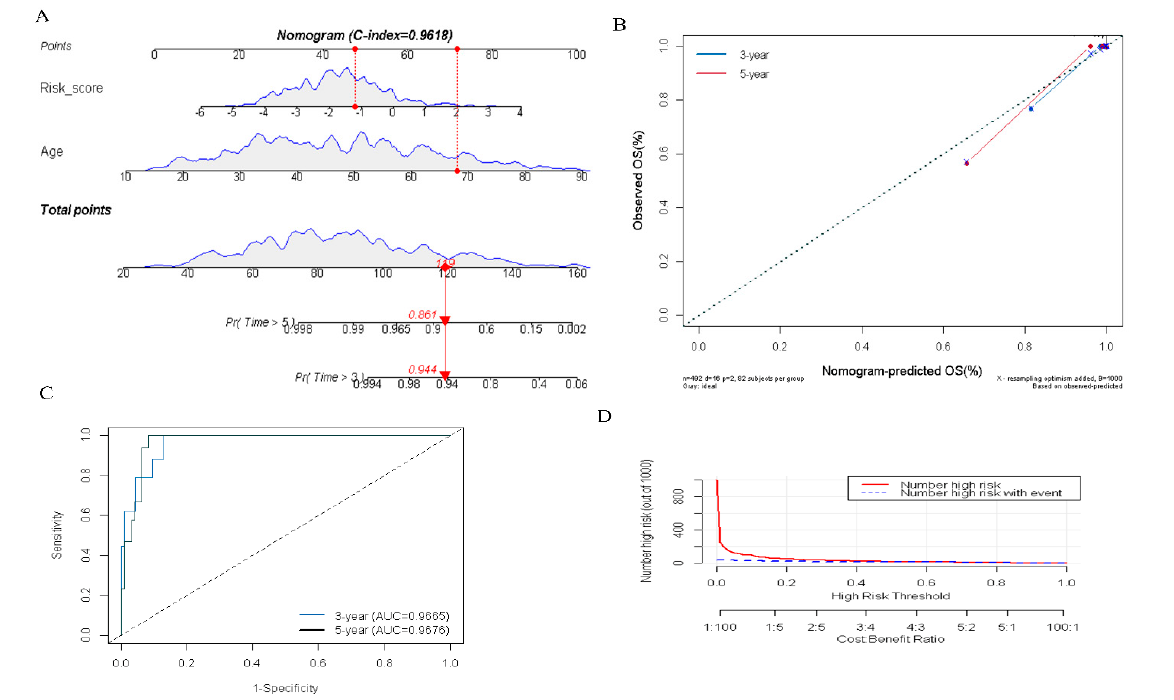
Figure 6. Construction and evaluation of an integrated nomogram. ( A ) Nomogram was developed based on DR ‐ lncRNA ‐ based risk scores and age. ( B ) Calibration plots were performed to evaluate the predictive performance of 3 ‐ and 5 ‐ year OS. ( C ) The AUC value of the nomogram. ( D ) DCA of the nomogram. OS: overall survival, AUC: the area under the receiver operating characteristic curve. DCA: decisions curve